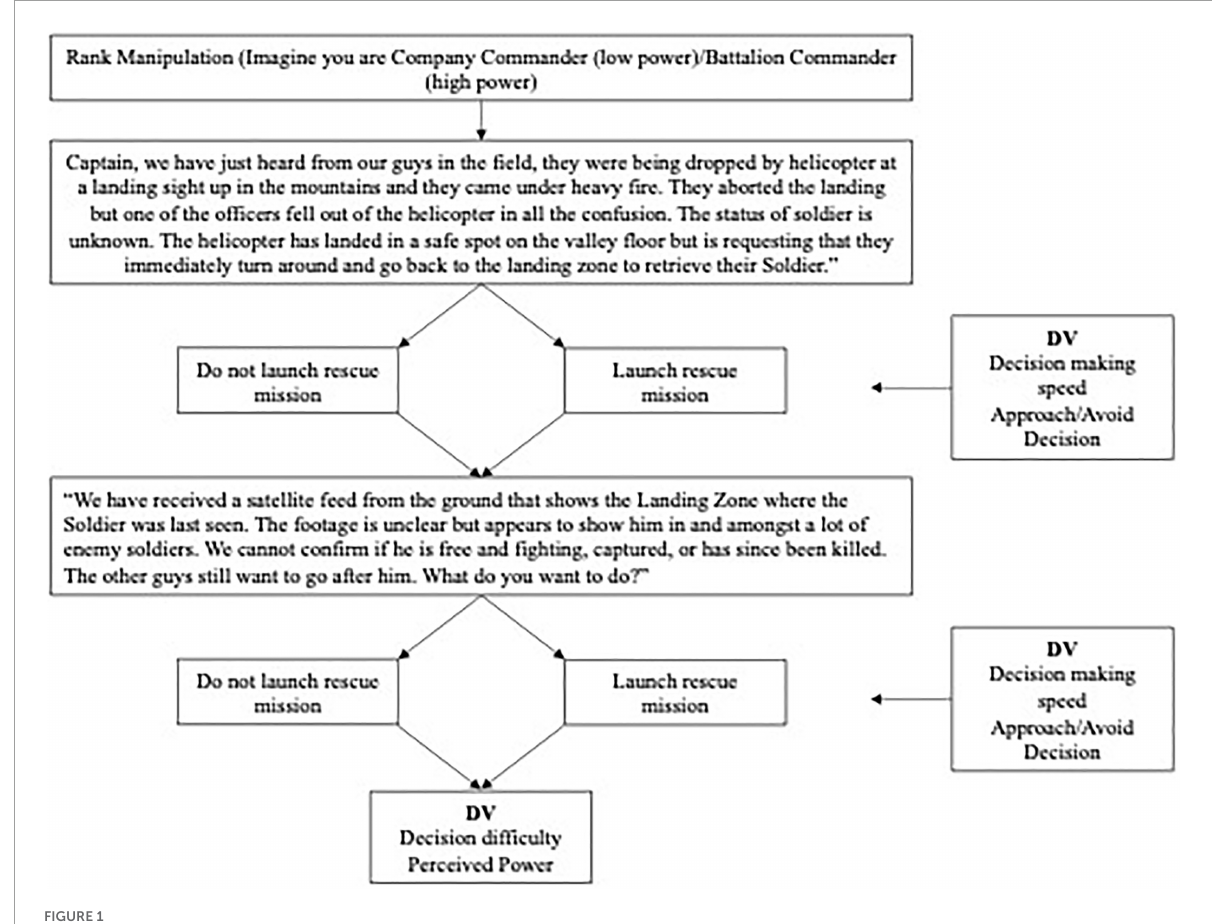
FIGURE1 Study flow with sample rank